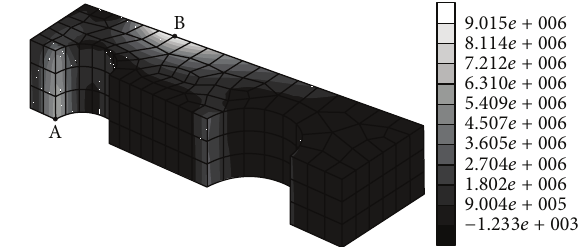
Figure 5: Stress distribution at EOL (unit: Pa).